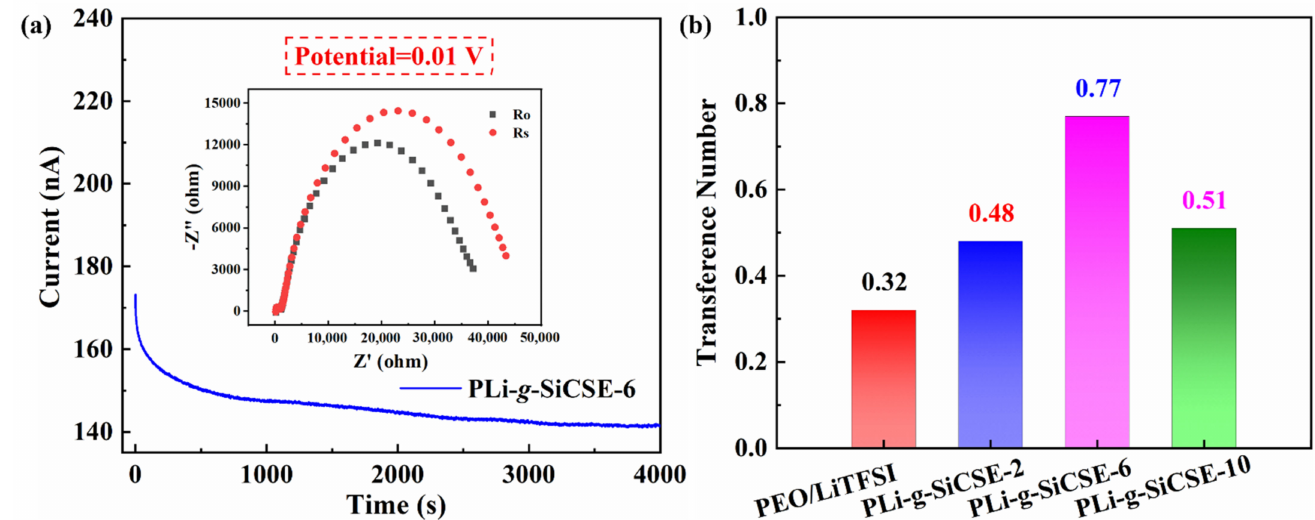
Figure 9. ( a ) The chronoamperometry profiles and AC impedance spectra before and after polariza- tion for the Li|PLi- g -SiCSE-6|Li symmetric cell with PLi- g -SiCSE-6, ( b ) t Li+ of the prepared CSEs membranes containing PEO/LiTFSI and different amounts of PLiSSPSI- g -SiO 2 .